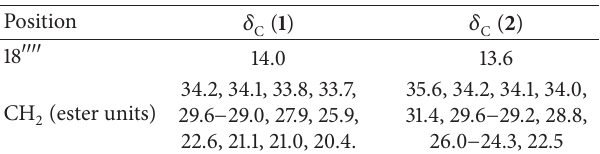
Table 1: 13 C NMR (150 MHz) spectral data of compounds 1 and 2